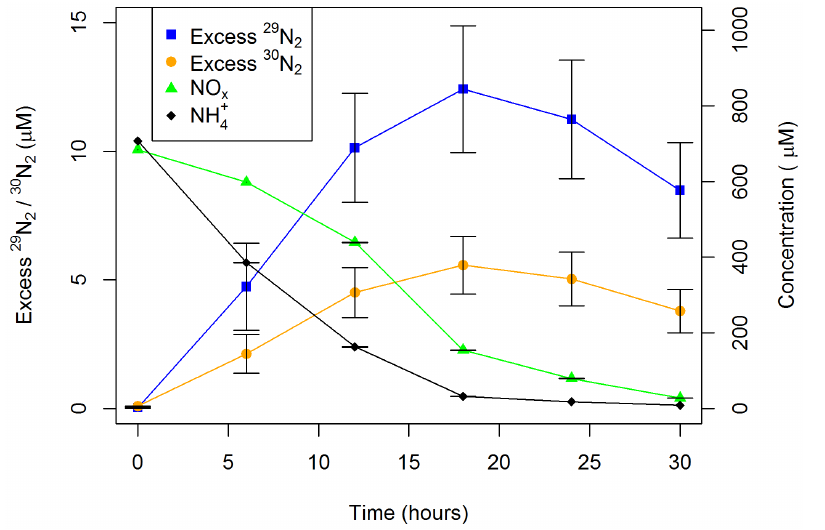
Figure 2. Nitrogen species concentrations. Examples of time series NH 4 + , NO x , excess 29 N 2 and 30 N 2 concentrations ( 6 standard error (n=4)) following dosing in the influent concentration experiment under very high nutrient dosing (20 mg N/L) measured in July 2012.